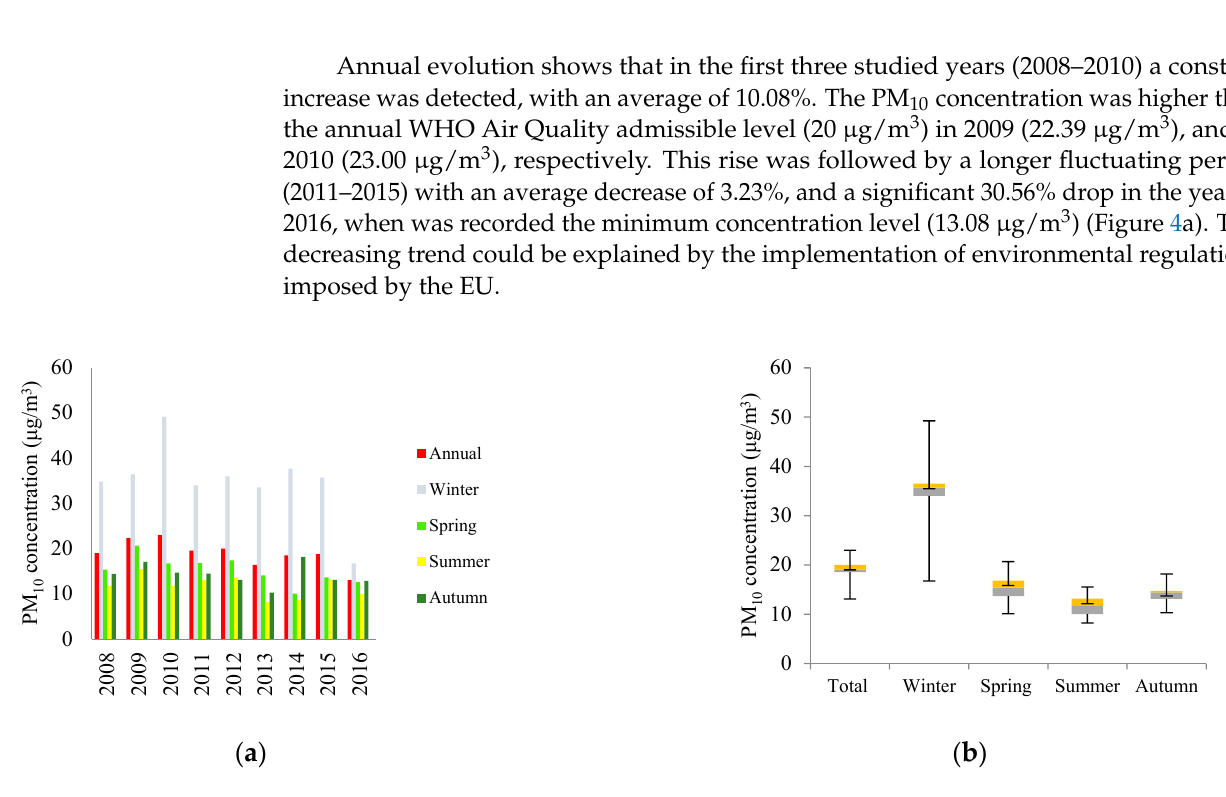
Figure 4. Annual ( a ) and seasonal ( b ) mean PM 10 concentration. 4.b Box-plot analysis of seasonal PM 10 concentrations The lower (grey) and upper (yellow) limits represent the first (25P) and third (75P) quartiles, and the ends of the whiskers represent the minimum and the maximum values.